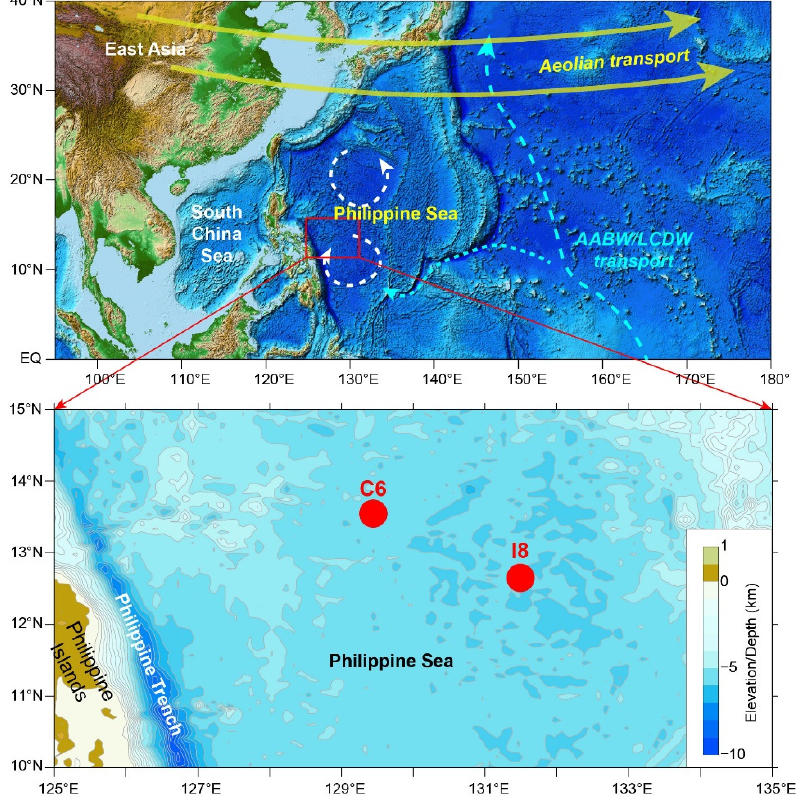
Figure 1. Schematic map showing the study area and oceanographic setting. All the flows were modified from previous studies [21,22]. The base map data were generated using the open, free software DIVA–GIS 7.5 (http://www.diva-gis.org/, accessed on 10 September 2021).